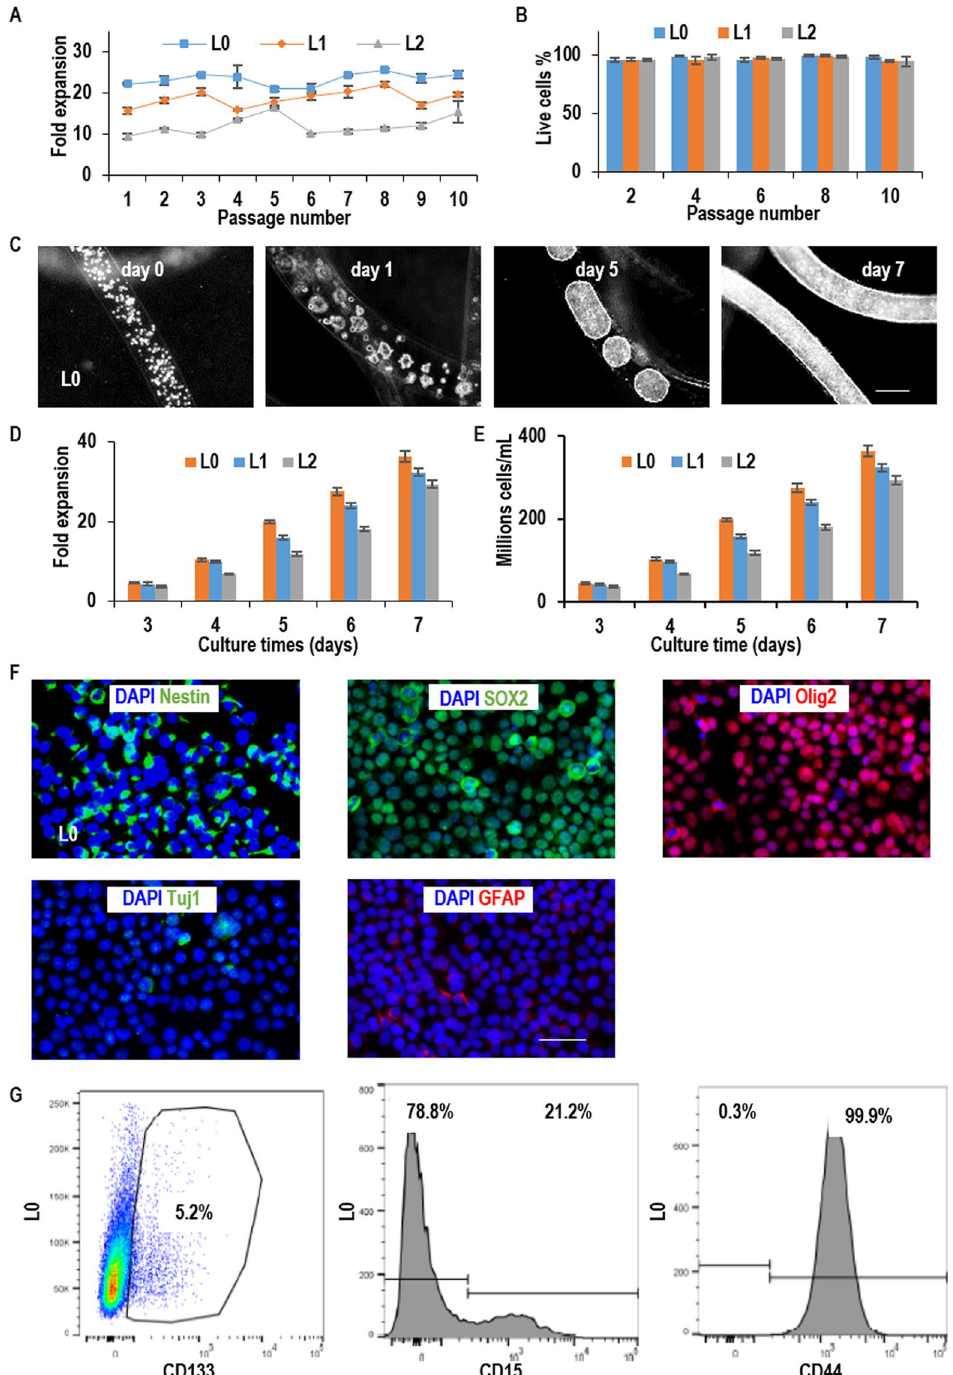
Figure 3. Long-term culturing of glioblastoma TICs in AlgTubes. ( A ) When seeded at 1.0 × 10 7 cells/mL, L0, L1 and L2 expanded ~23-, 19- and 12-fold/passage/5 days, respectively, along a 10-passage culture with ( B ) cell viability was > 95%. ( C ) Microscopy images of L0 cells on day 0, 1, 5 and 7 at passage 10. ( D , E ) The expansion fold and volumetric yield of TICs from day 3 to day 7 at passage 10. When seeded at 1 × 10 7 cells/mL, L0, L1 and L2 expanded 36-, 32- and 29-fold, yielding 3.6 × 10 8 , 3.2 × 10 8 and 2.9 × 10 8 cells/mL by day 7, respectively. ( F ) Immunostaining of the cultured TICs. Cells were released from AlgTubes on day 7 at passage 10 and plated on a Laminin-coated plate overnight before fixing and staining. Majority of L0 were Nestin + , SOX2 + and Olig2 + . Few L0 cells were Tuj1 + and GFAP + . ( G ) Flow cytometry analysis showed that 5.2% L0 cells were CD133 + , 21.2% L0 cells were CD15 + and 99.9% L0 cells were CD44 + . Error bars represent the standard deviation (n = 3). Scale bar: ( C ) 200 µ m; ( F ) 50 µ